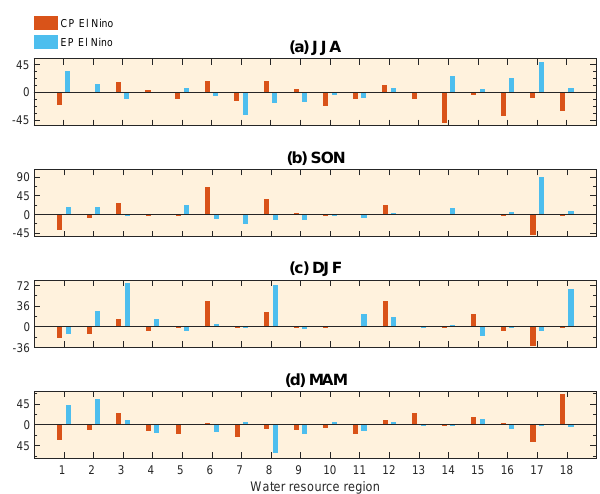
Figure 5. Seasonal domain-averaged runoff anomalies (unit: mm) for the 18WRRs at (a) JJA, (b) SON, (c) DJF, and (d) MAM during CP- and EP-El Niño